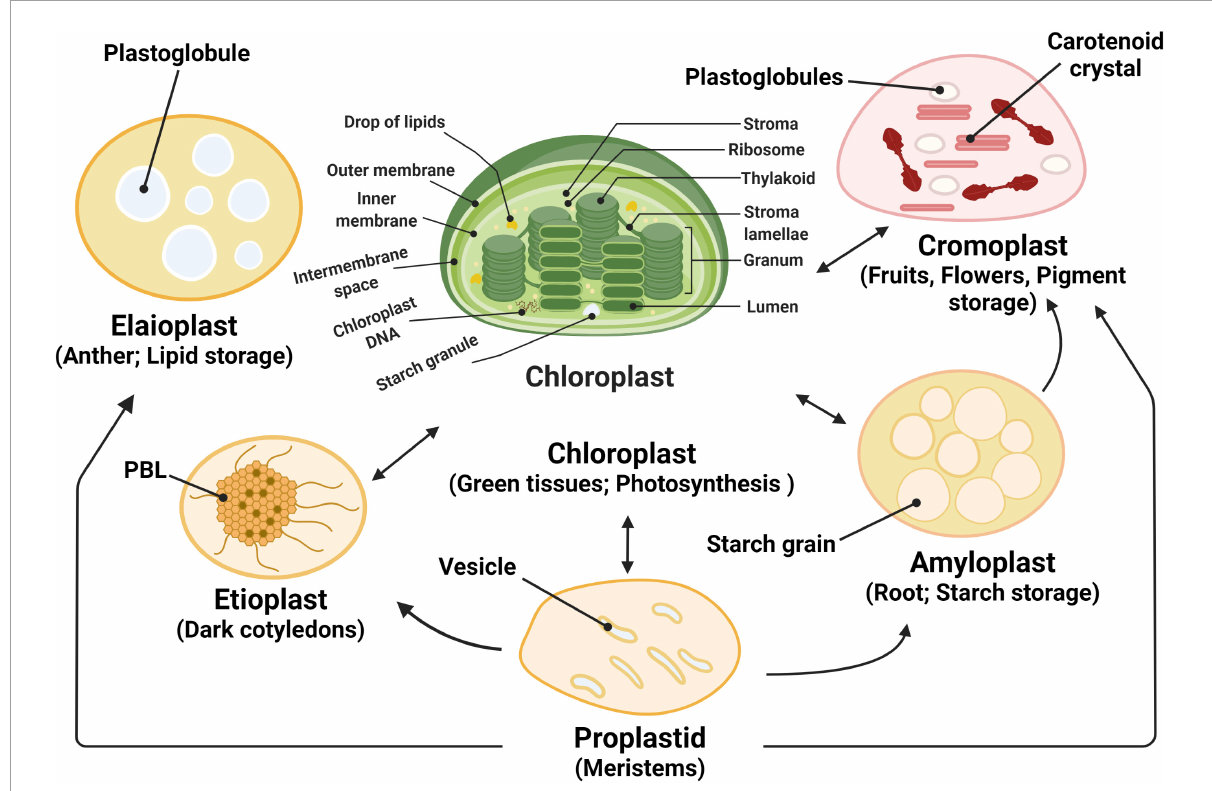
FIGURE1 Plastid functions and plastid interconversions. Scheme of the chloroplast with its different compartments. The internal thylakoid membranes fold into stacked grana disks that interconnect via stroma lamellae. Thylakoid membranes enclose the lumen compartment. Plastids exist in different forms, and their identity and abundance are controlled by developmental and environmental cues. Different types interconvert (see the arrows) following a reorganization of the organellar proteome, a process that is controlled by the differentially regulated import of nucleus-encoded proteins. Chloroplasts are photosynthetic plastids, amyloplasts are starch-storing plastids, chromoplasts are carotenoid pigment-accumulating plastids, and proplastids are undifferentiated plastids that can differentiate into the different types of plastids. Etioplasts are chloroplast progenitors that form in darkness and accumulate chlorophyll precursors [in paracrystalline structures called prolamellar bodies (PLB)] that rapidly differentiate upon illumination. Elaioplasts store lipids in lipid droplets known as plastoglobules and exist, for example, in tapetal cells during pollen